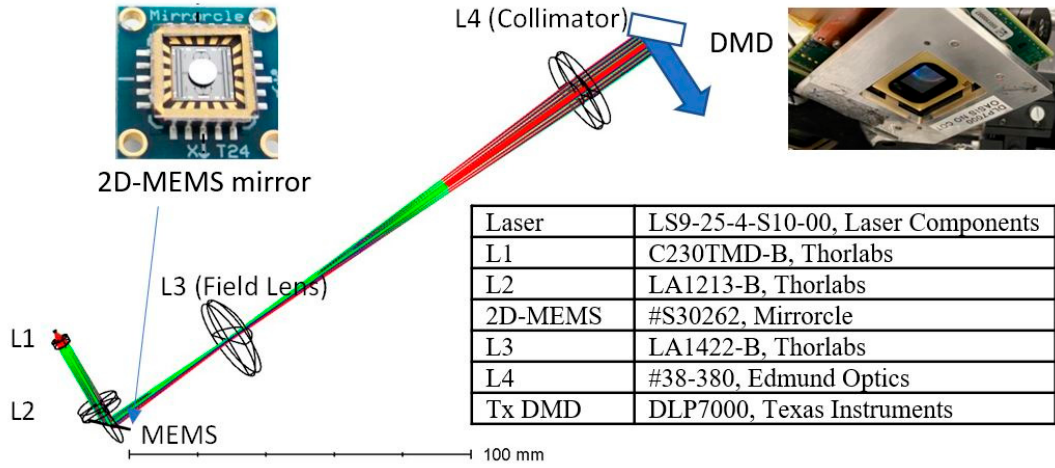
Figure 3. A ray-tracing diagram of the lidar transmitter to expand the beam while matching the pupils of the 2D-MEMS mirror and DMD.